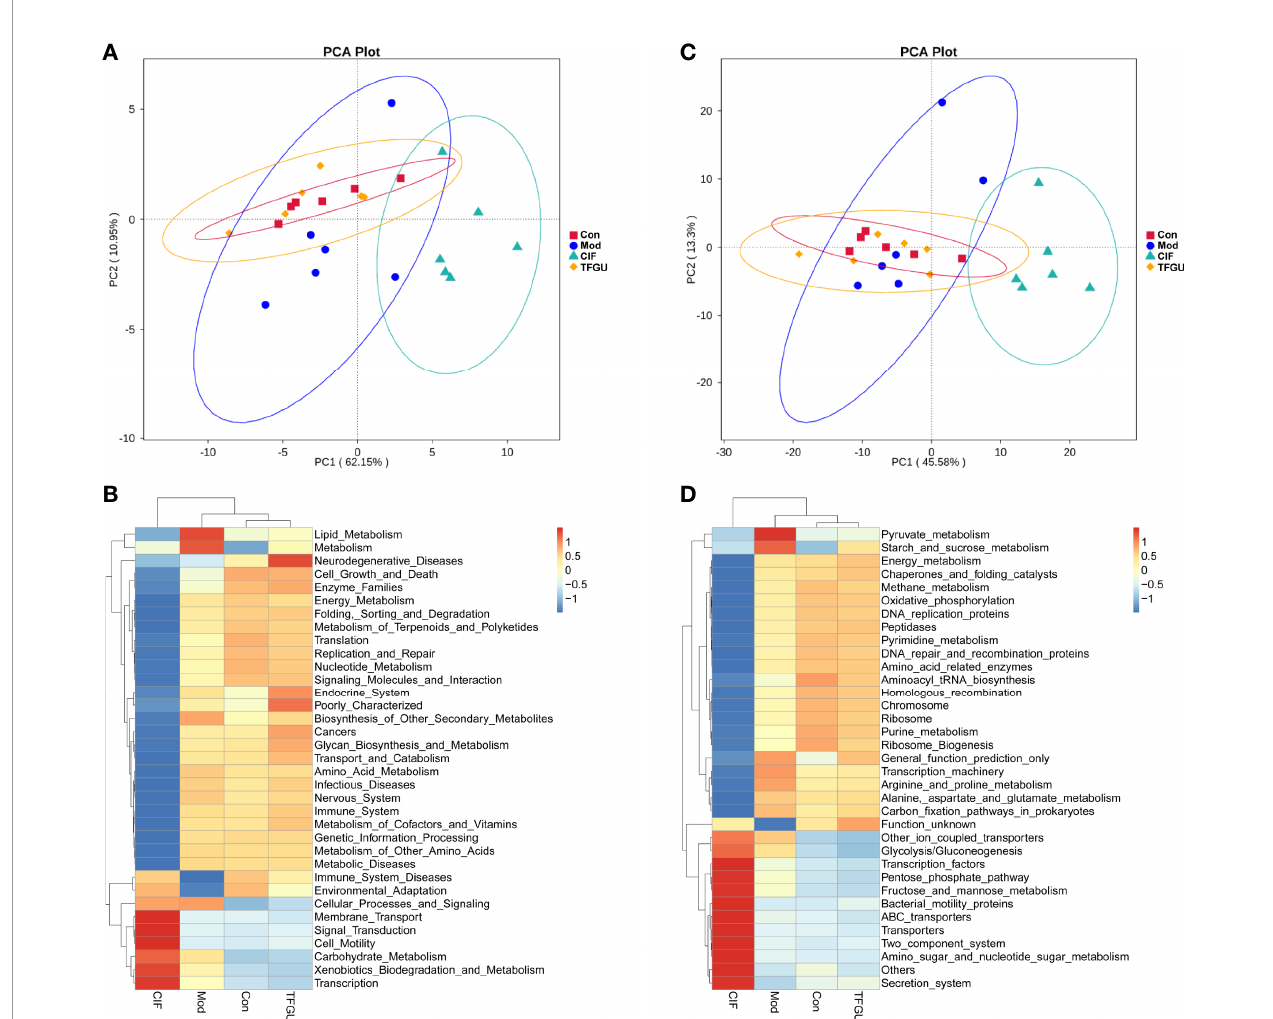
FIGURE 5 | The principal component analysis (PCA) and heatmap of Kyoto Encyclopedia of Genes and Genomes (KEGG) pathways in levels II (A, B) and III (C, D) functional prediction by Phylogenetic Investigation of Communities by Reconstruction of Unobserved States (PICRUSt). The values correspond to standardized Z scores generated from function